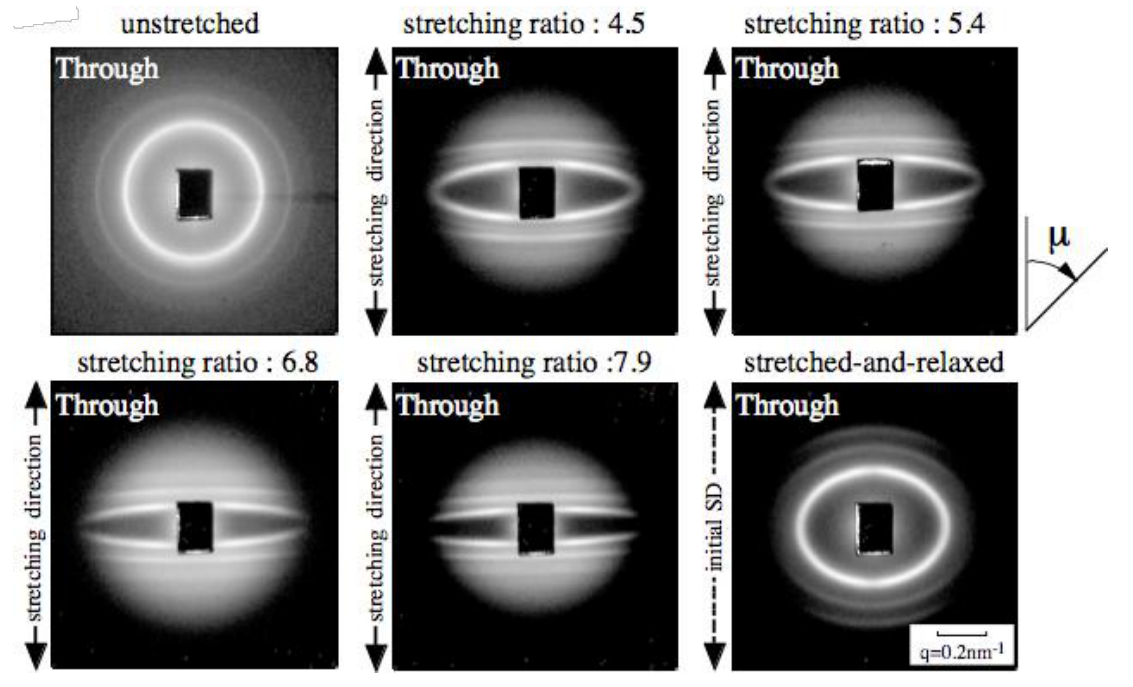
Figure 4. 2d-SAXS patterns obtained from in situ measurements of the sample under the uniaxial stretching using the homemade stretching device. The stretching direction is